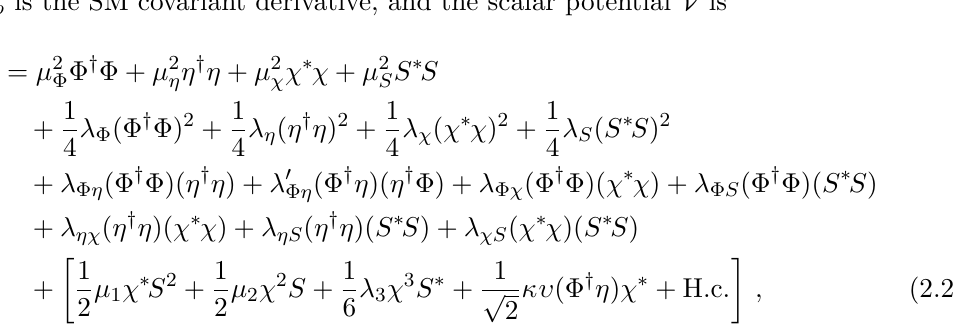
The renormalizable Lagrangian for the interactions of the scalar particles in this model with one another and with the SM gauge bosons